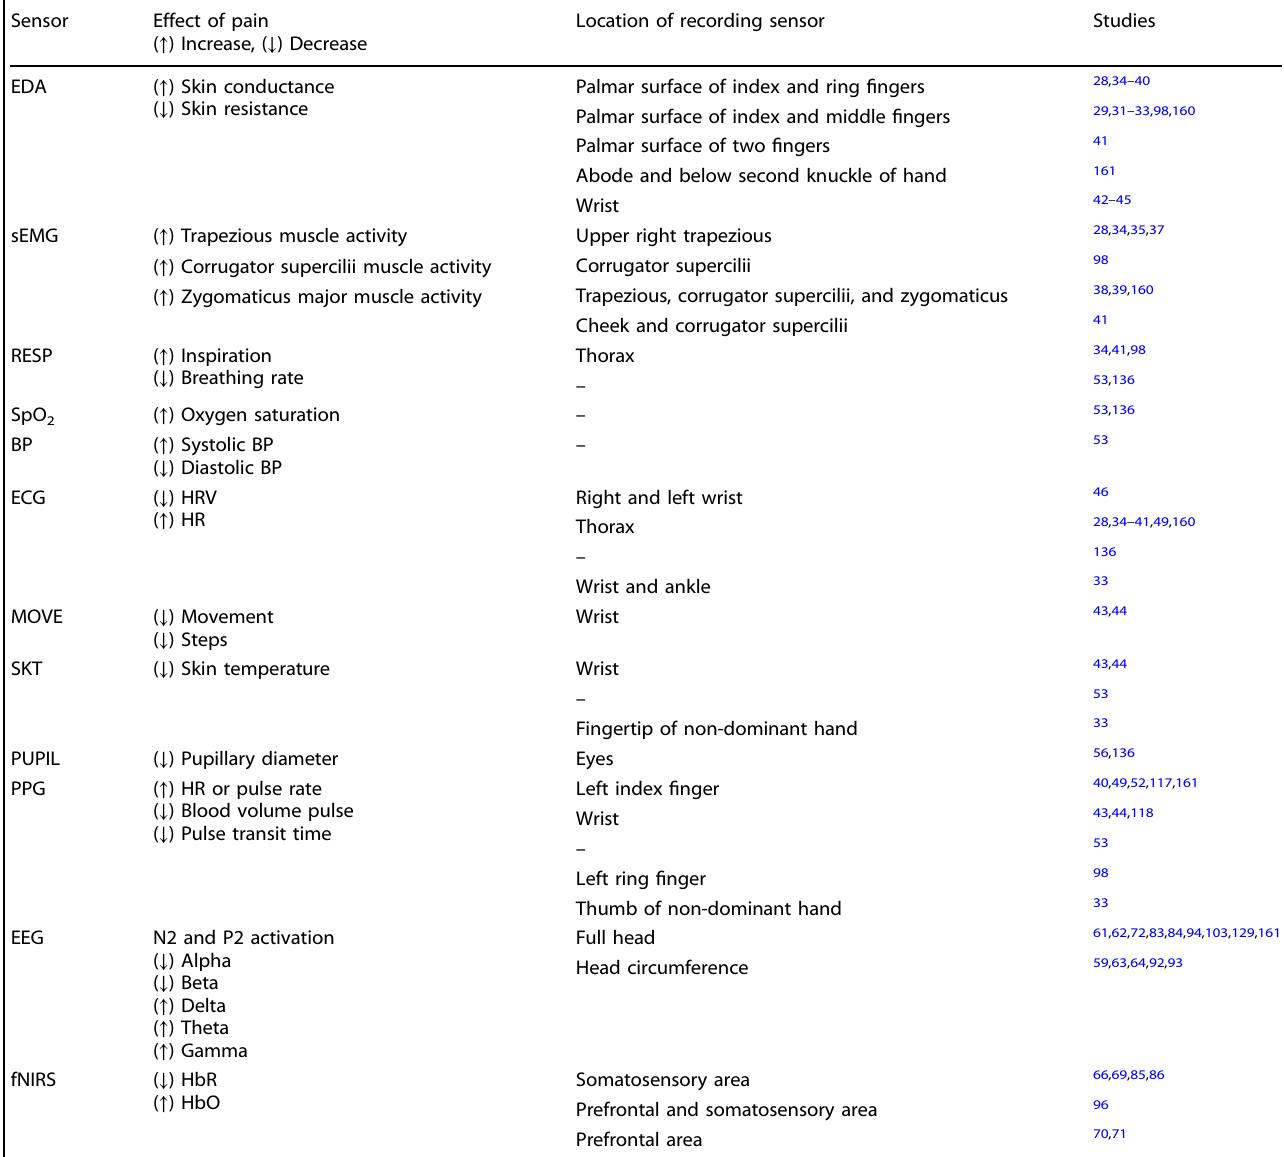
Table 2. Summary of neurophysiological sensors used in the reviewed literature, including the anatomical location of recording sensor and the expected neurophysiological response to